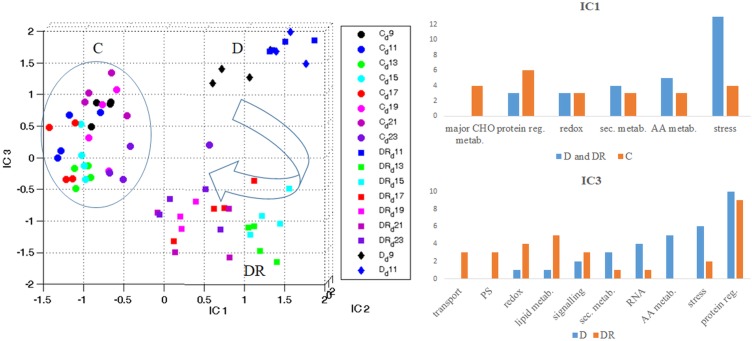
Overview of the protein stress and recovery trajectory. Independent component analysis (ICA) of all quantifiable leaf proteins of B. vulgaris control (C) plants as well as plants exposed to drought (D) and recovery (DR) at different days during treatment (9-23). IC1 separates proteins according to stress severeness (C versus D and DR). Functional categories of protein groups of highest loadings (IC1) are visualized in bar-plots (see also Supplementary Table S3a). IC3 separates proteins mostly involved in stress from those of recovery (D versus DR). Functional categories of protein groups with highest loadings (IC3) are visualized in bar-plots (see also Supplementary Table S3b).